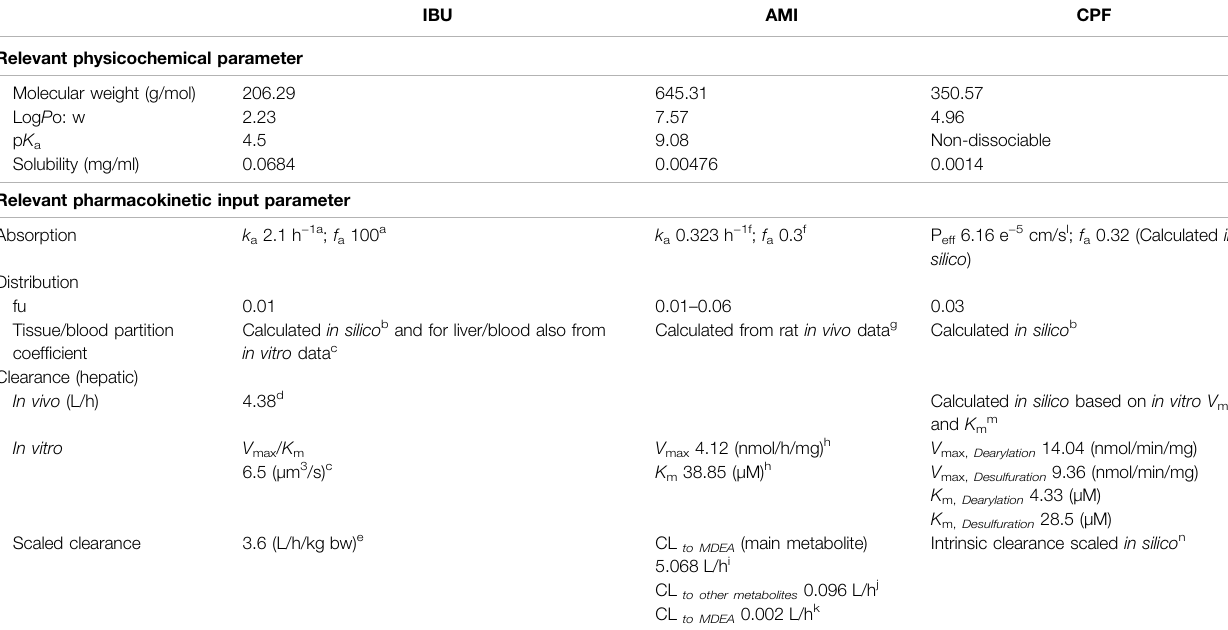
TABLE 1 | Selected physicochemical and physiological human PBK model input parameters for the three tested